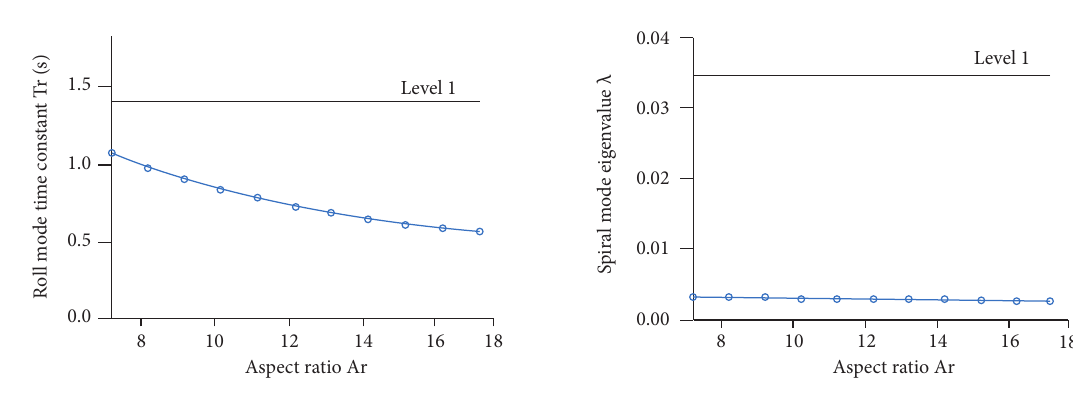
Figure 4. Influence of Ar on roll mode and spiral